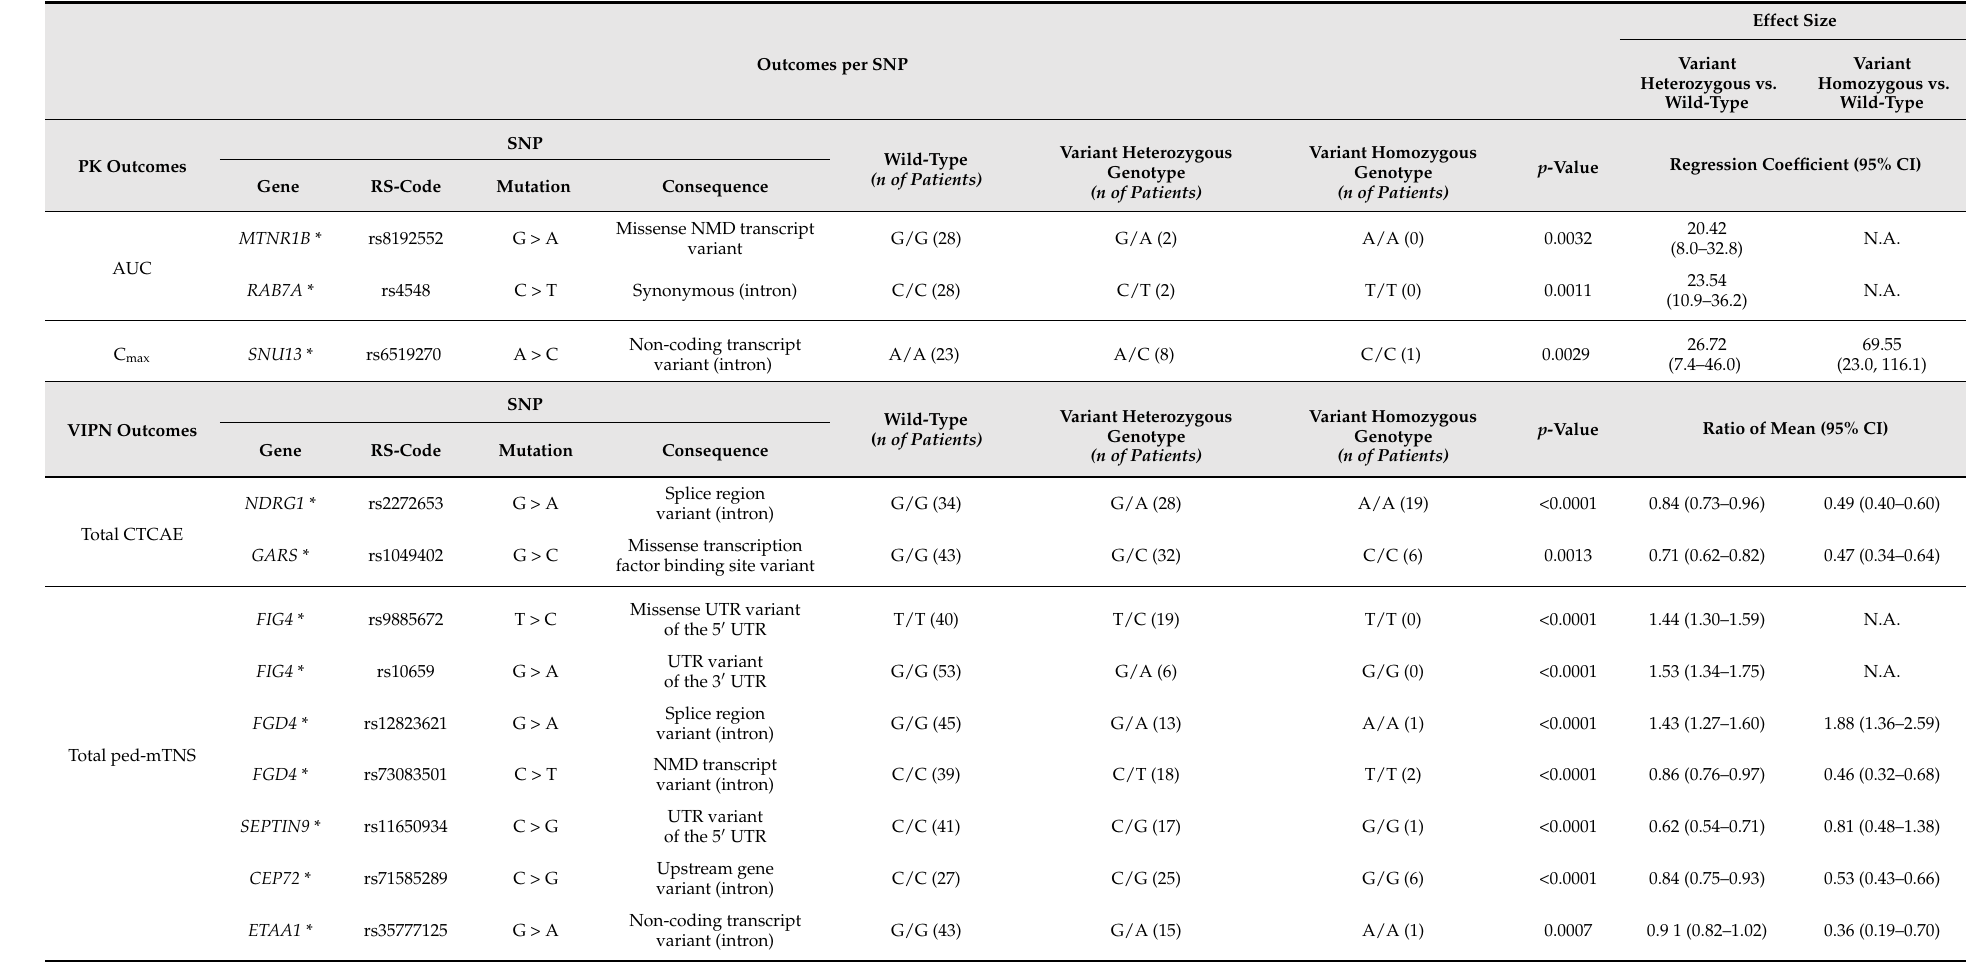
Table 2. Associations between single-nucleotide polymorphisms (SNPs), VCR PK and